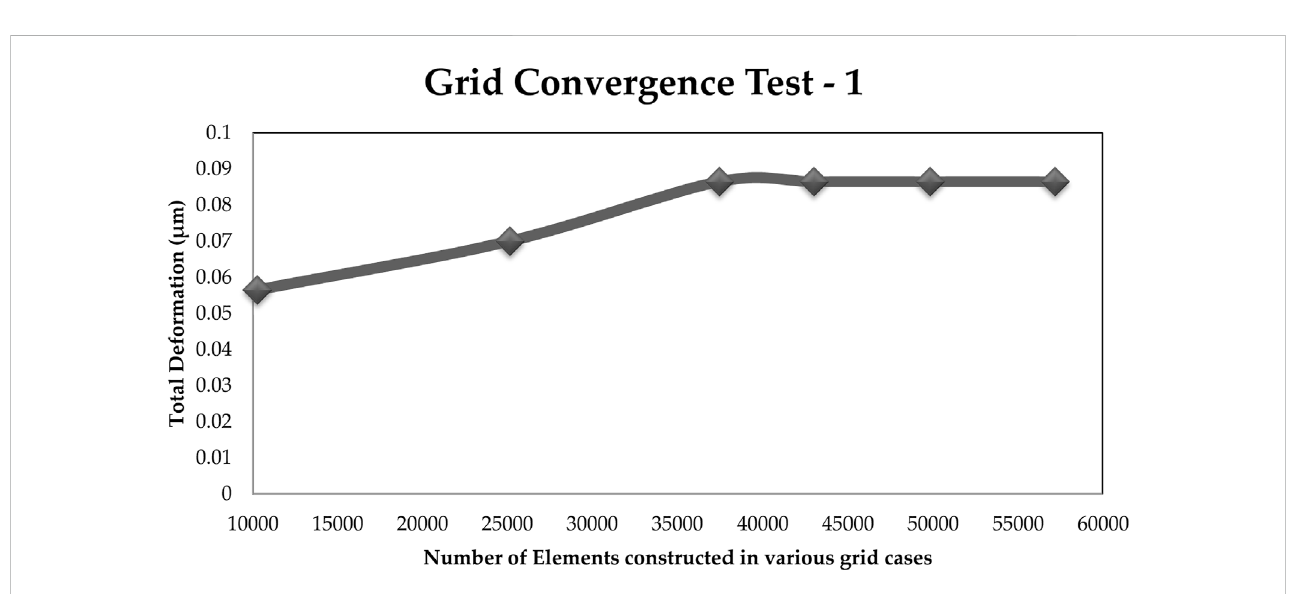
Total deformation on full fuselage of RUAV with